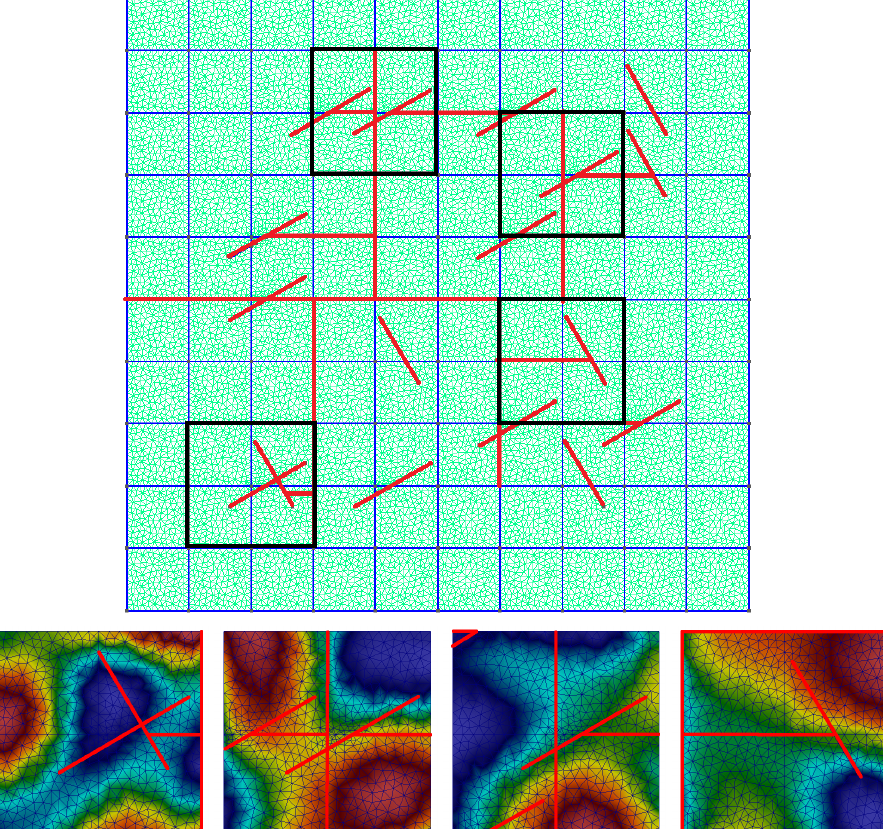
Figure 5. An example of four local domains ω l